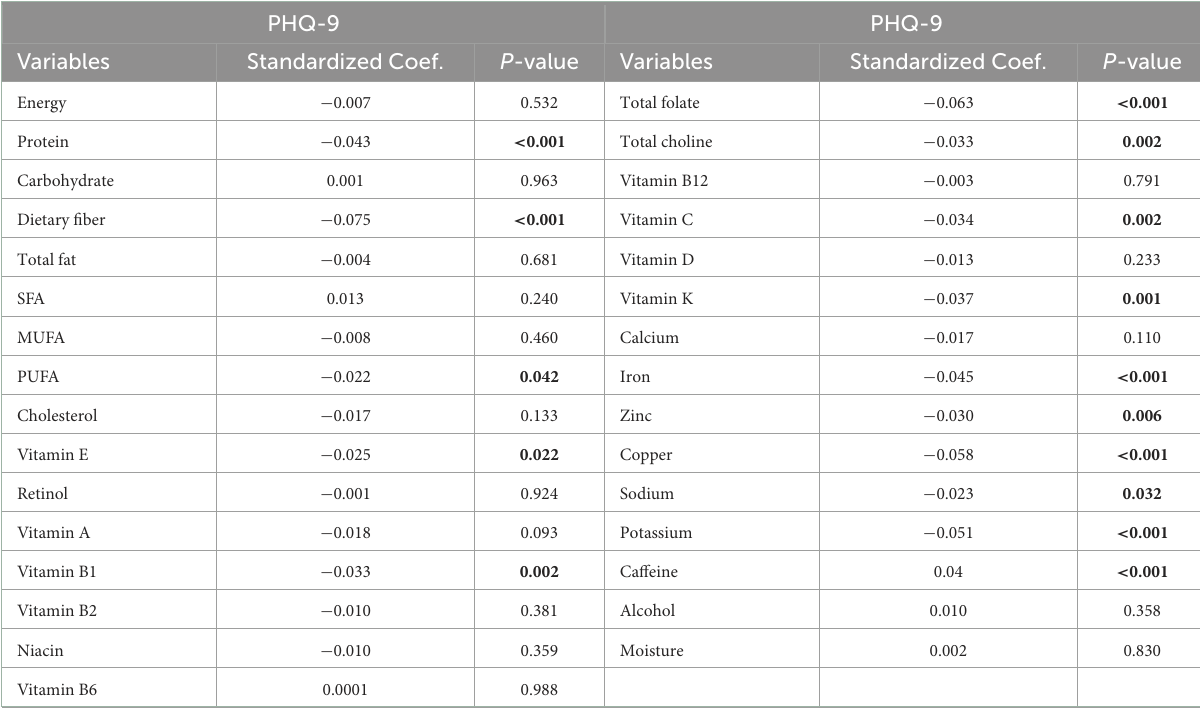
TABLE 2 Simple linear regression between nutrient intake and PHQ-9 score in the